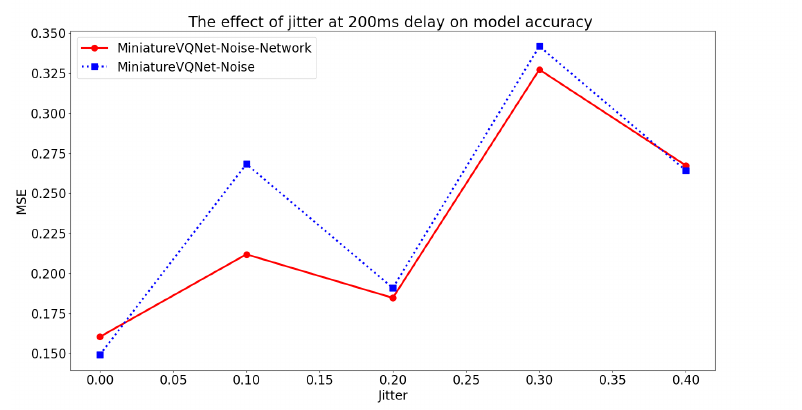
Figure 7. The effect of jitter on prediction